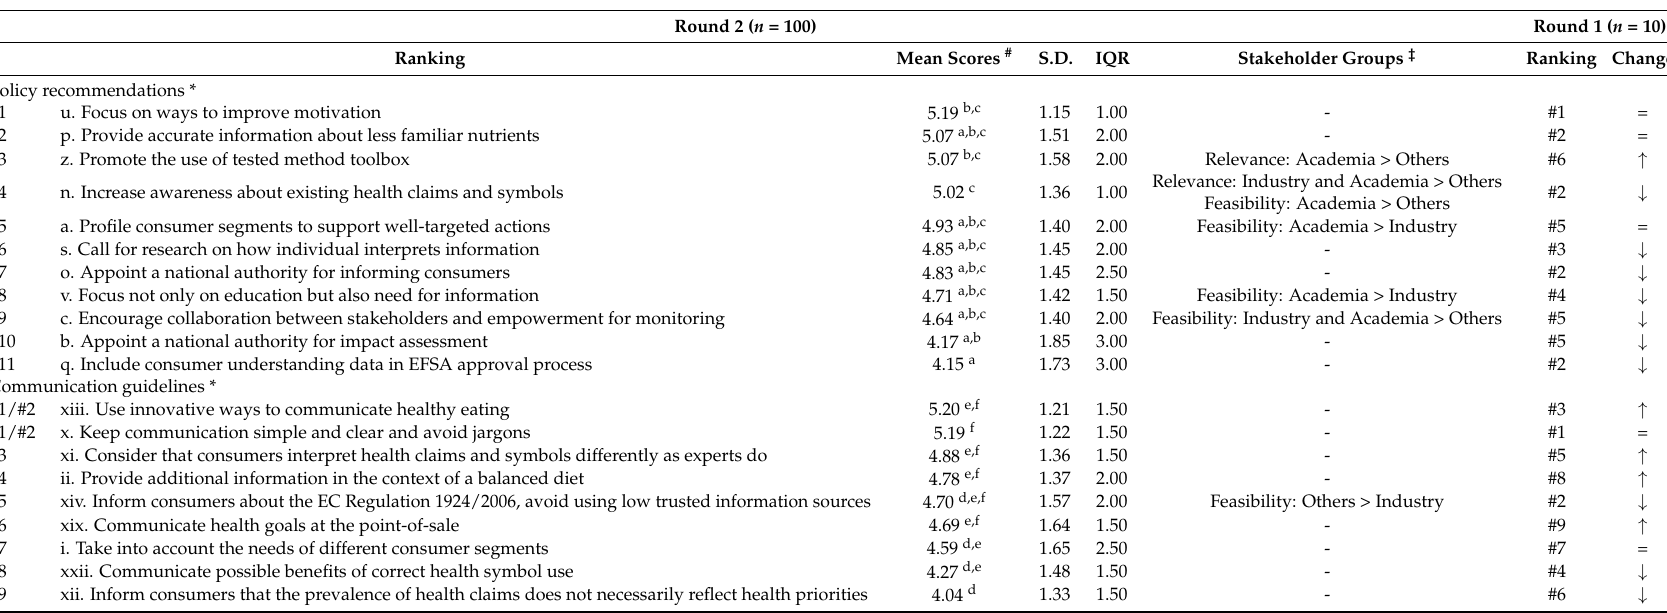
Table 4. Summary of the evaluation of policy recommendations and communication guidelines based on the Delphi method round 1 and round 2 and confirmed in round 3. Round 2 ( n = 100) Round 1 ( n = 10) Ranking Mean Scores # S.D.